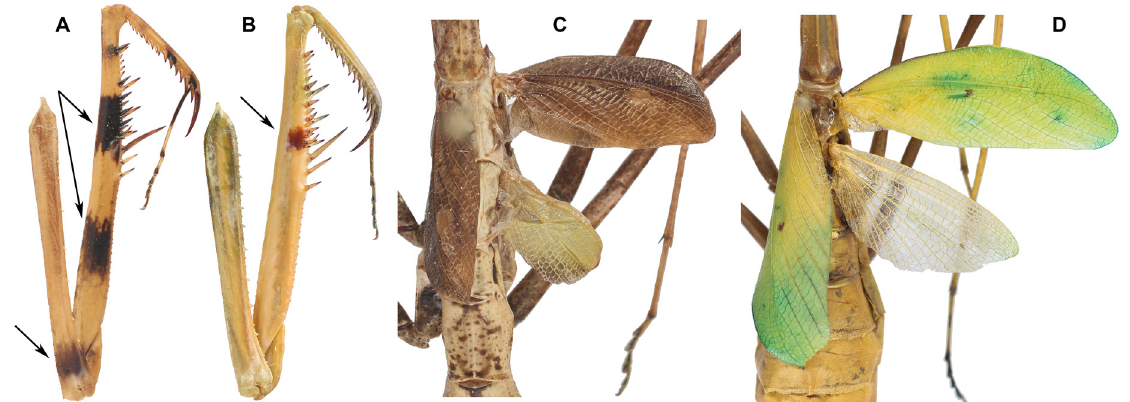
C . Euchomenella macrops (Saussure, 1870). B , D . Phasmomantella nuichuana gen. et sp. nov., ♀. Not to